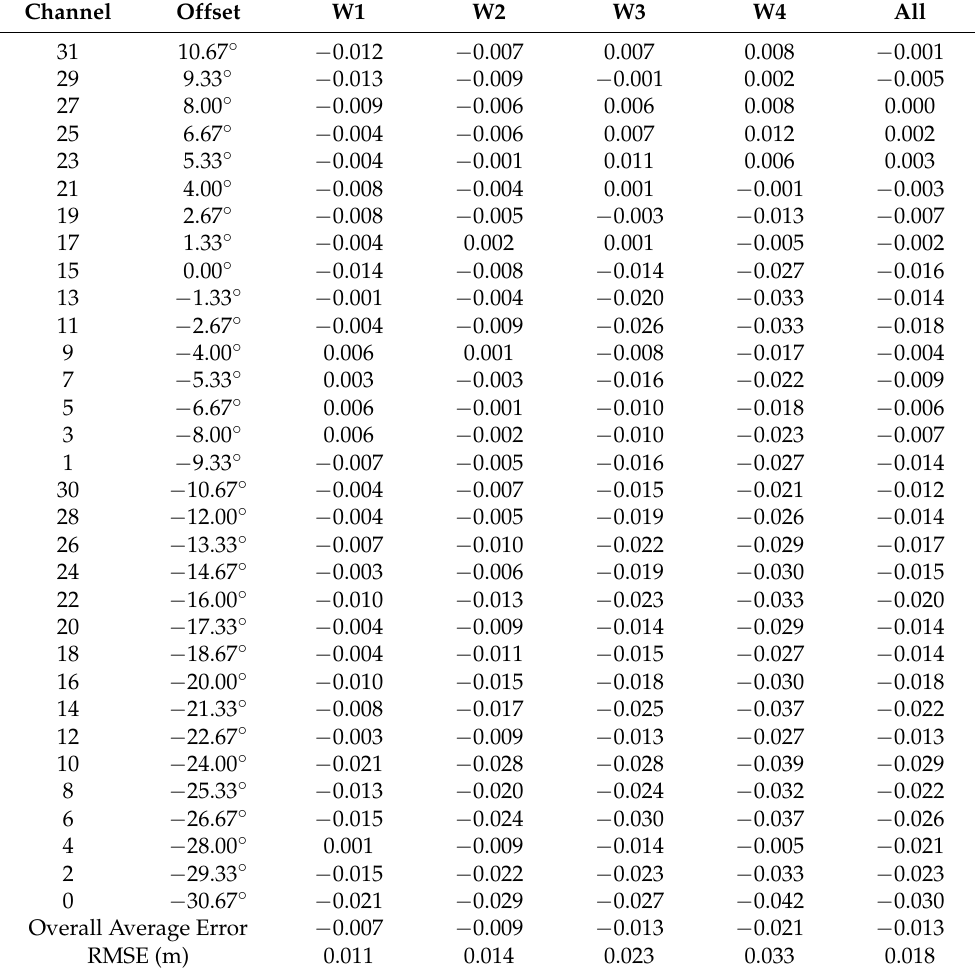
Table A2. Calculated error (m) per individual channel, per subsection of target surface in Velodyne ® HDL–32E during 30 m, day experiment. Subsections are labeled W1 through W4, with W1 being the lowest observed and W4 being the